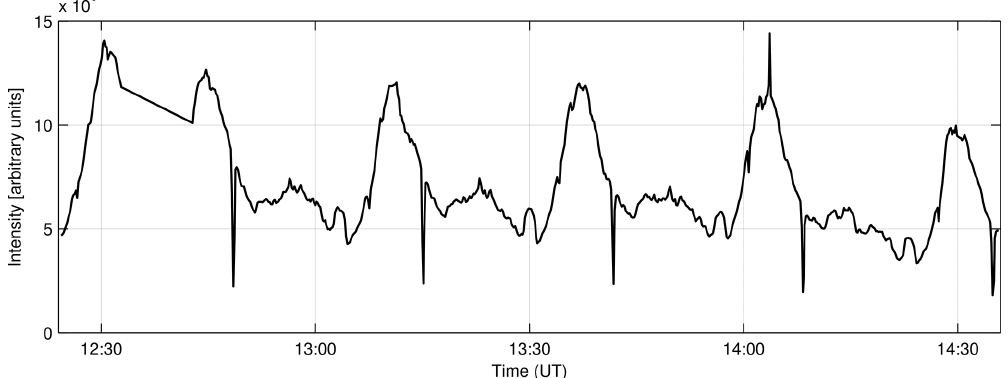
Figure 2. An example of a time series of the intensity of the spectrum as measured with the DOAS instrument from the rotating tower platform on 22 April 2016 between 12:25 and 14:35UT. The sharp dips indicate a decrease in intensity due to pointing towards a skyscraper, which blocks the view of the